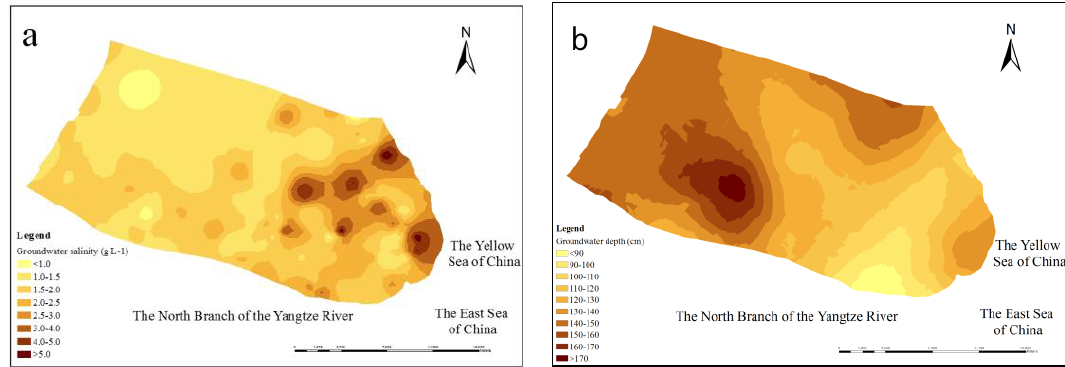
Figure 9. Spatial distributions of groundwater depth and salinity in the Yangtze River Estuary in 2008. ( a ) Spatial distributions of groundwater salinity; ( b ) Spatial distributions of groundwater depth